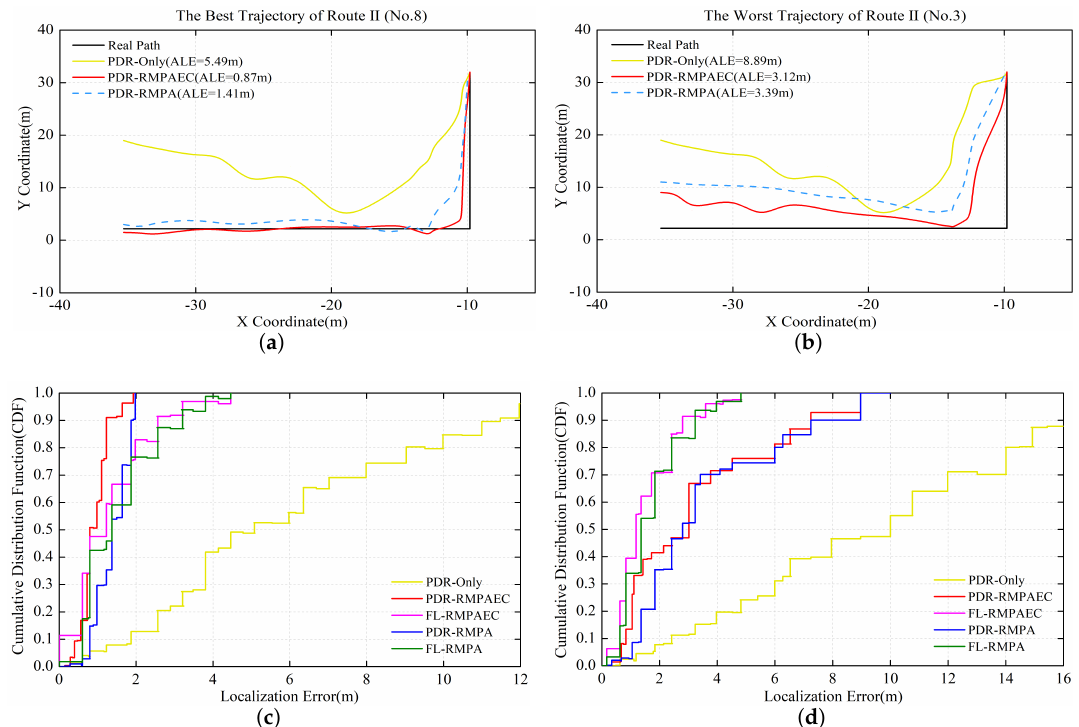
Figure 7. Localization results in Route II: ( a ) the best No. 8 PDR-RMPAEC trajectory with ALE = 0.87 m; ( b ) the worst No. 3 PDR-RMPAEC trajectory with ALE = 3.12 m; ( c ) CDF of localization error of the No. 8 trajectory; and ( d ) CDF of localization error of the No. 3